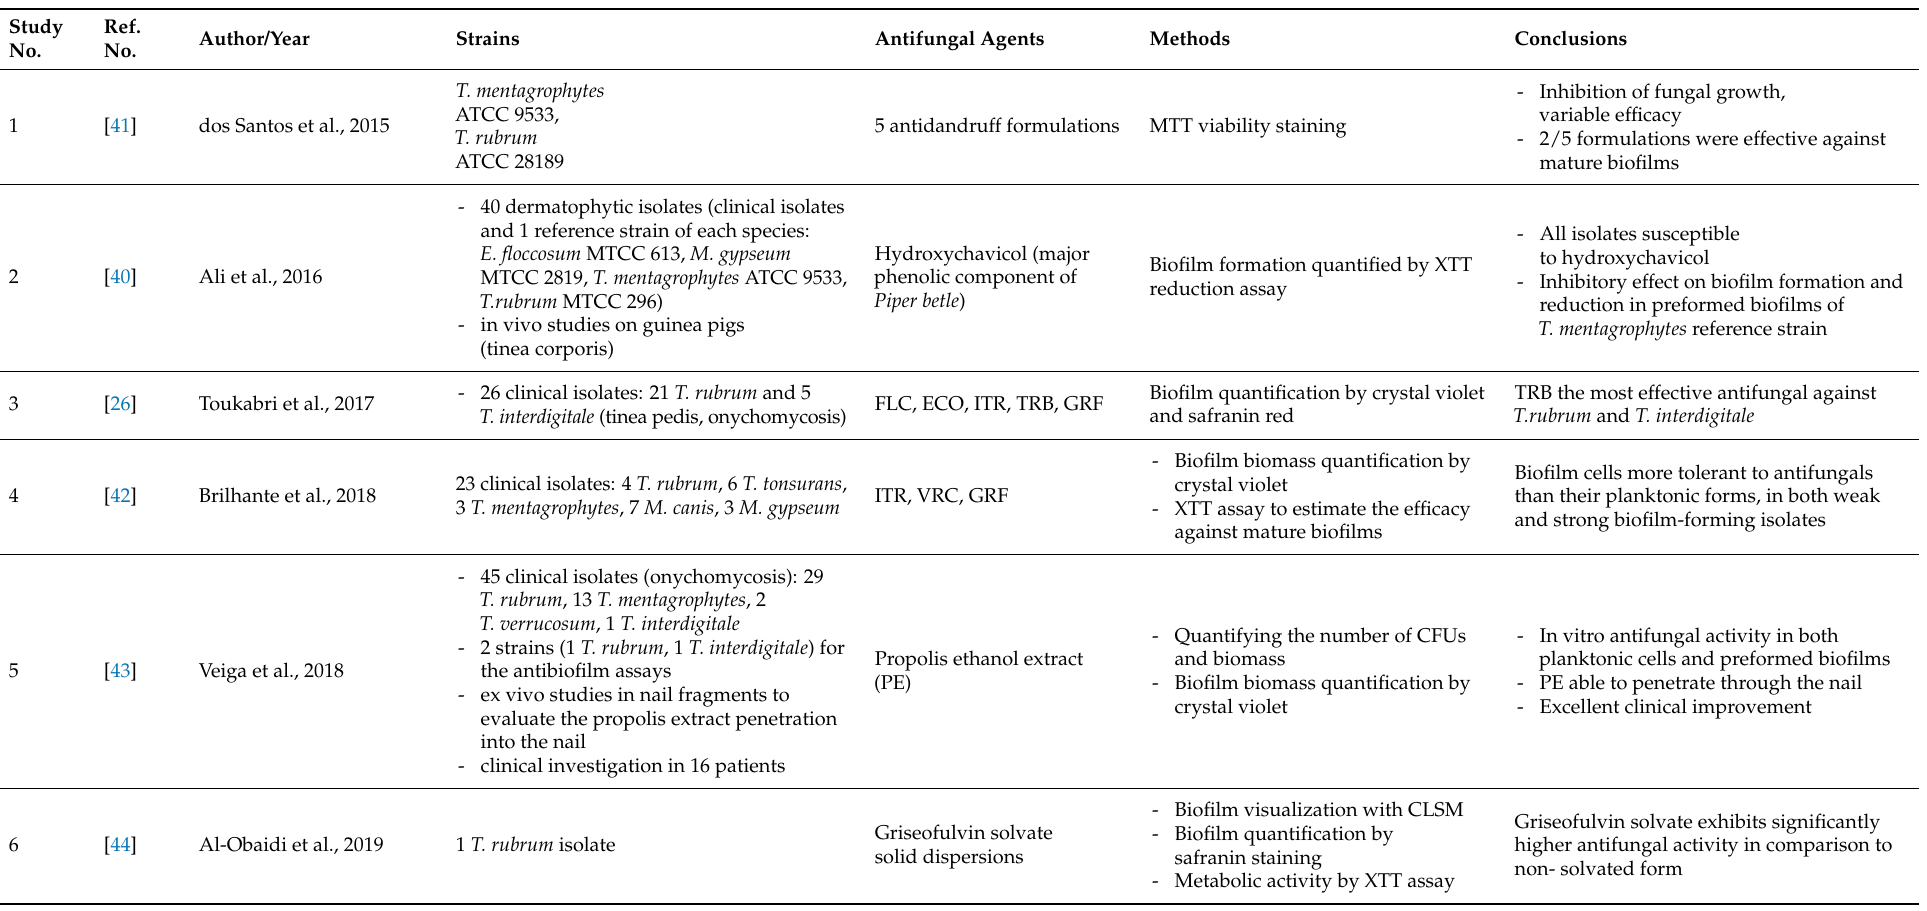
Table 1. Summary of the antibiofilm susceptibility testing studies on dermatophytes, including the dermatophytic strains, methods used and the main conclusions. Study